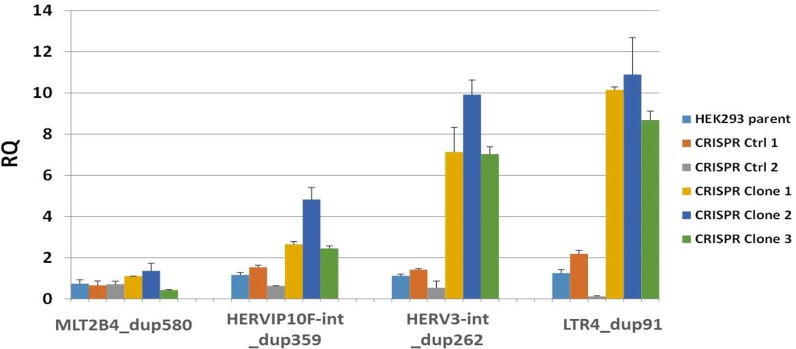
Human endogenous retrovirus expression in TRIM28 CRISPR clones.The expression of four human endogenous retroviruses up-regulated in TRIM28-mutant WT was evaluated in HEK293 cells (HEK293 parent), two CRISPR clones with normal TRIM28 gene and protein levels (CRISPR Ctrl 1 and 2), and three TRIM28 knockdown CRISPR clones (CRISPR Clone 1, 2, and 3) by SYBR Green PCR. The endogenous retrovirus levels were normalized to GAPDH and are presented as the relative quantitative (RQ) value compared to HEK293 parent cells. Error bars represent the standard deviation of two PCR replicates.